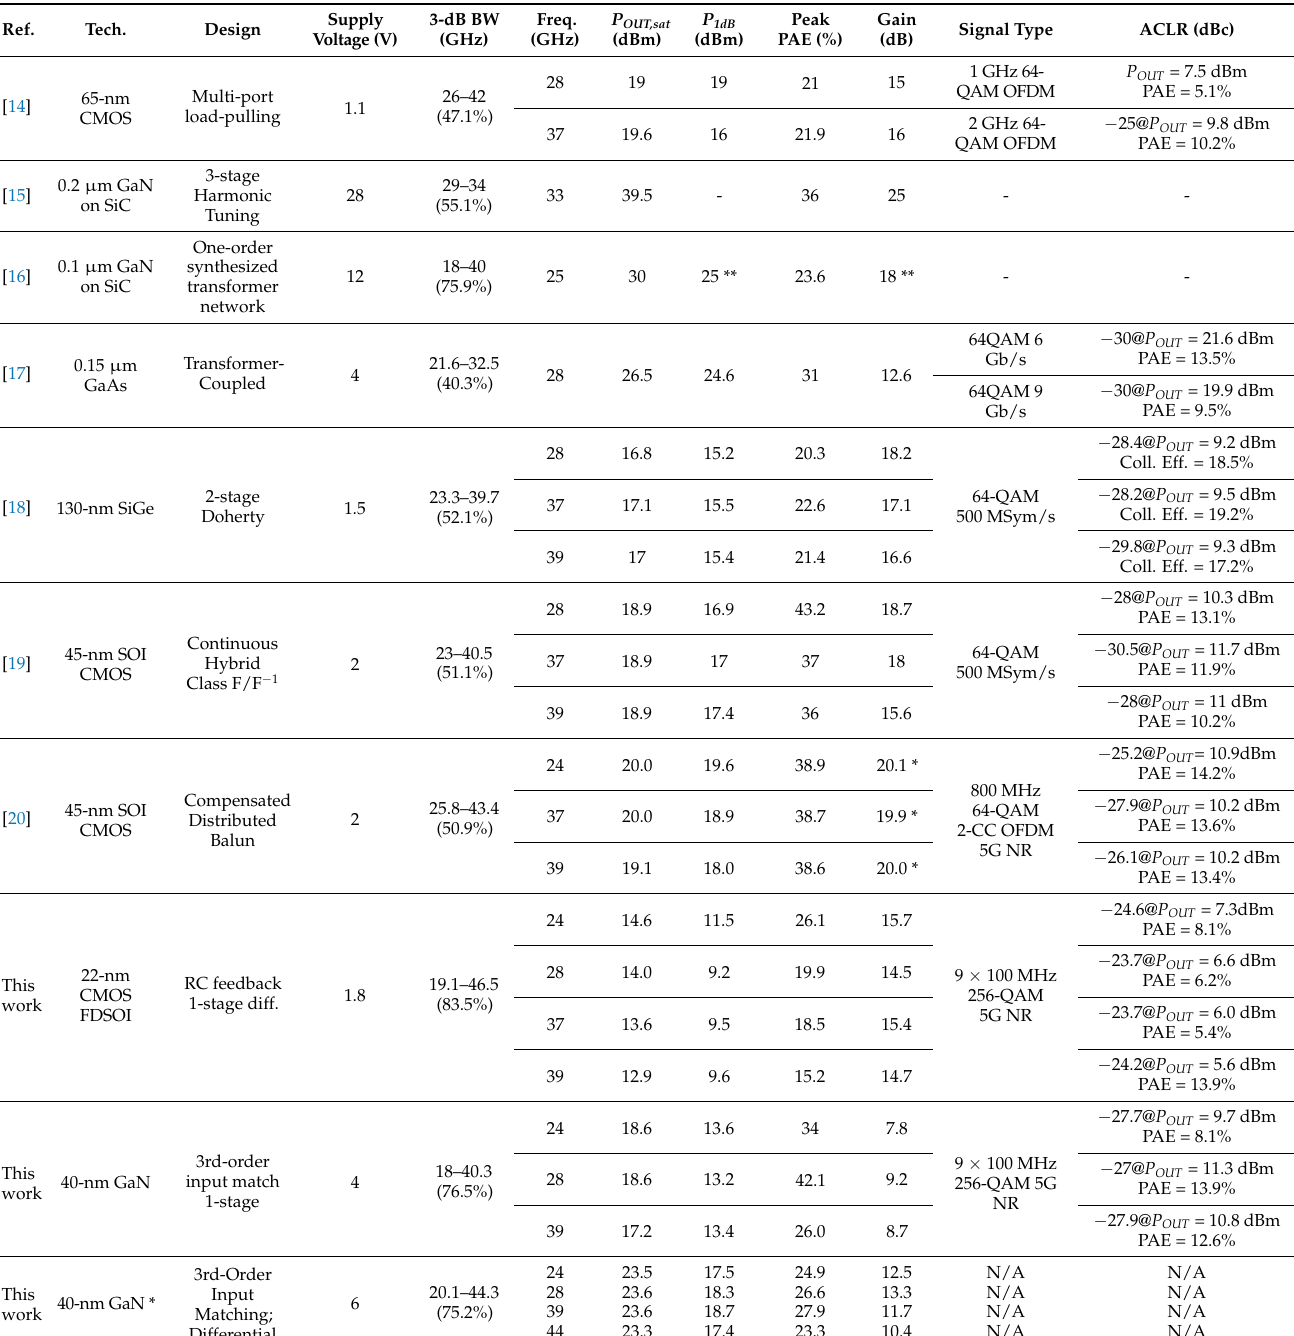
Table 2. Literature comparison of the three broadband mm-wave PAs presented in this work to other broadband state-of-the-art mm-wave